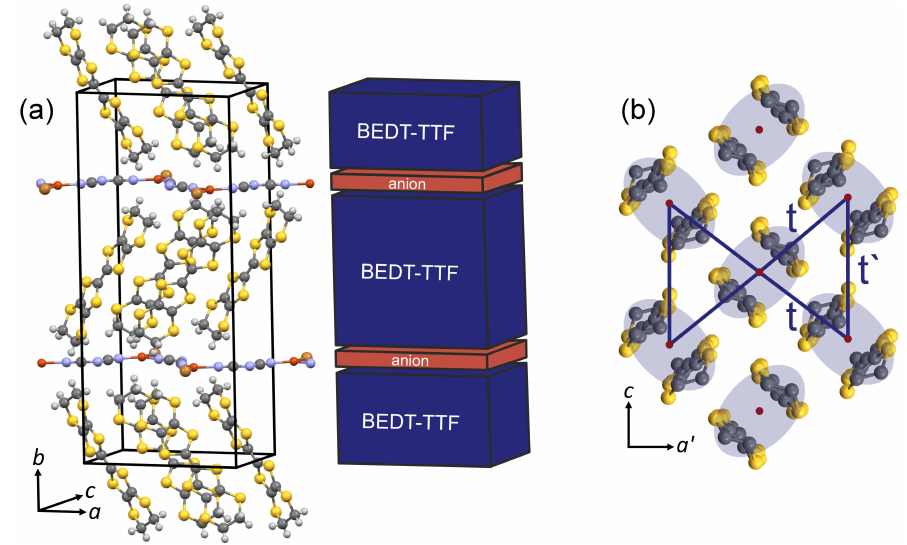
Figure 1. ( a ) crystal structure (left) of κ -(BEDT-TTF) 2 Cu[N(CN) 2 ]Z with Z = Br, Cl, which can be simply viewed as alternating blocks (right) of conducting and insulating layers with the donor ET and polymeric chain-forming acceptor Cu[N(CN) 2 ]Z molecules, respectively. The box represents the unit cell hosting four formular units; ( b ) spatial arrangement of the ET molecules in the κ -phase viewed along the long axis of the molecules. Two ET molecules form a dimer (shaded ellipse), whereas two dimers are arranged almost orthogonal to each other. Considering the dimers as the basic structural units, the conduction band is effectively half-filled and the charger carriers reside on a triangular lattice with two transfer integrals t and t